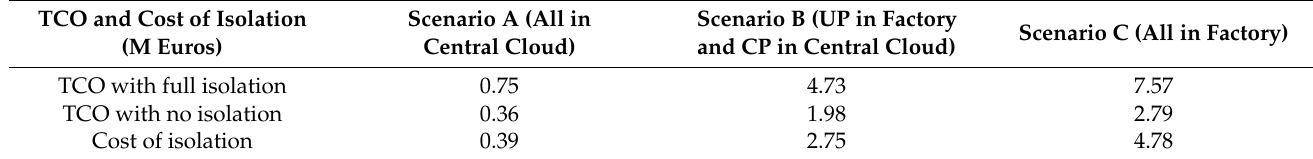
Table 5. Cost of